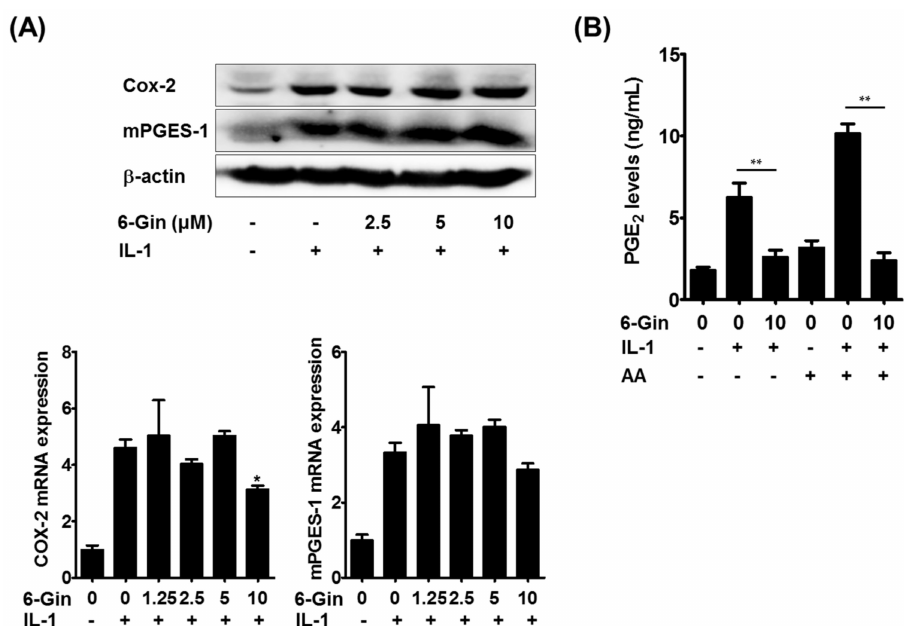
Figure 5. 6-Gingerol inhibits IL-1-induced PGE 2 synthesis without affecting the expression of COX (cyclooxygenase)-2 and microsomal PGES-1 (mPGES-1). ( A ) POBs were treated with or without 6-gingerol (6-Gin, 1.25–10 µ M) and IL-1 (10 ng/mL) for 24 h. The protein and mRNA levels of COX-2 and mPGES-1 were determined via Western blot (upper panel) and real-time PCR (lower panel); ( B ) POBs were treated with or without IL-1 for 24 h, and the culture medium was replaced with fresh medium. Cells were then treated with or without 6-gingerol (10 µ M) for 30 min and further incubated with or without arachidonic acid (AA, 5 µ M) for 15 min. PGE 2 concentrations in culture medium were determined using enzyme immunoassay (EIA). * p < 0.05 vs. treatment with IL-1 alone. ** p <